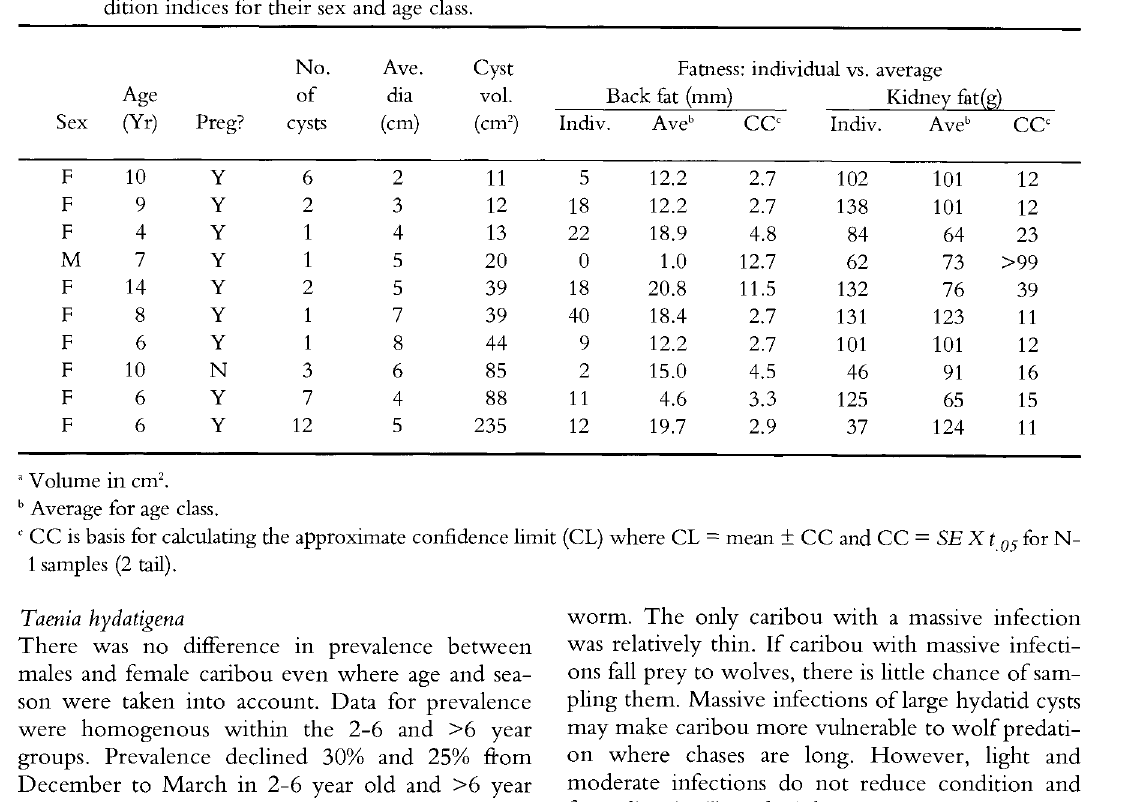
Table 3. Condition indices of the 10 caribou most intensively infected with Echinococcus granulosus and average con dition indices for their sex and age